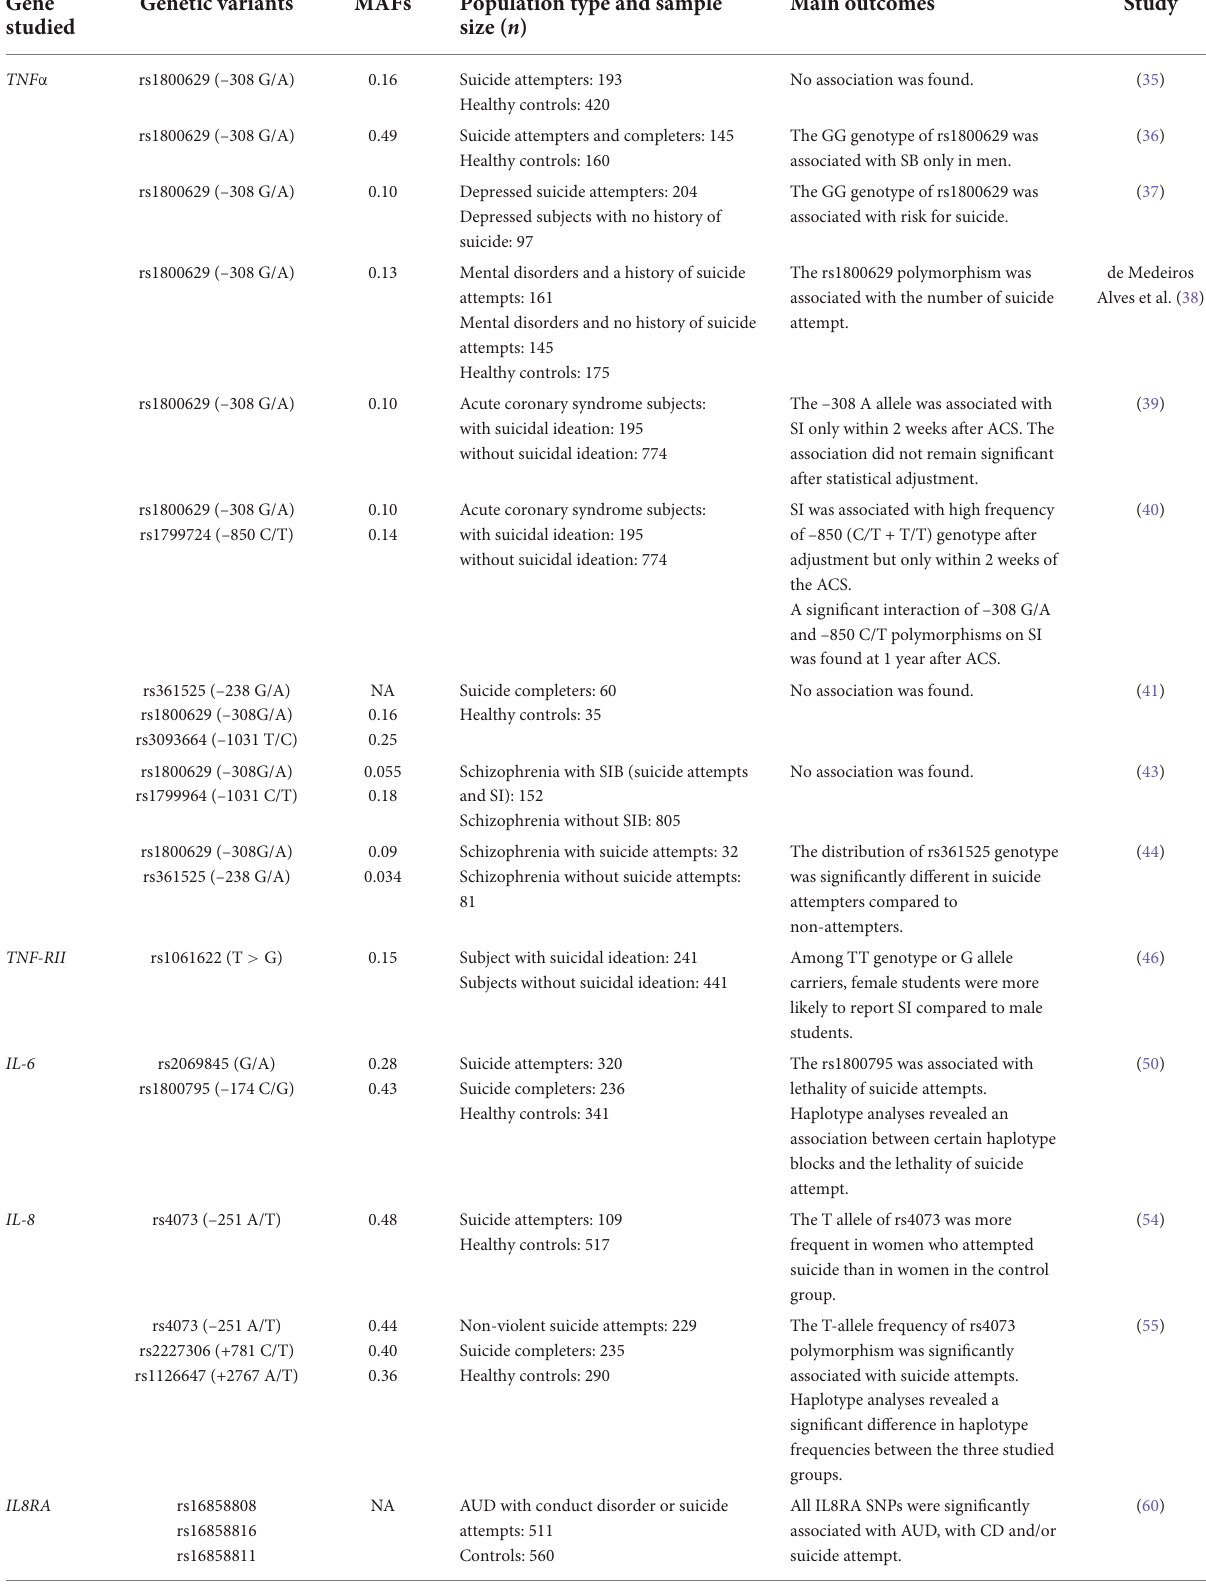
TABLE 2 Association between suicidal behavior and SNPs in genes encoding molecules involved in